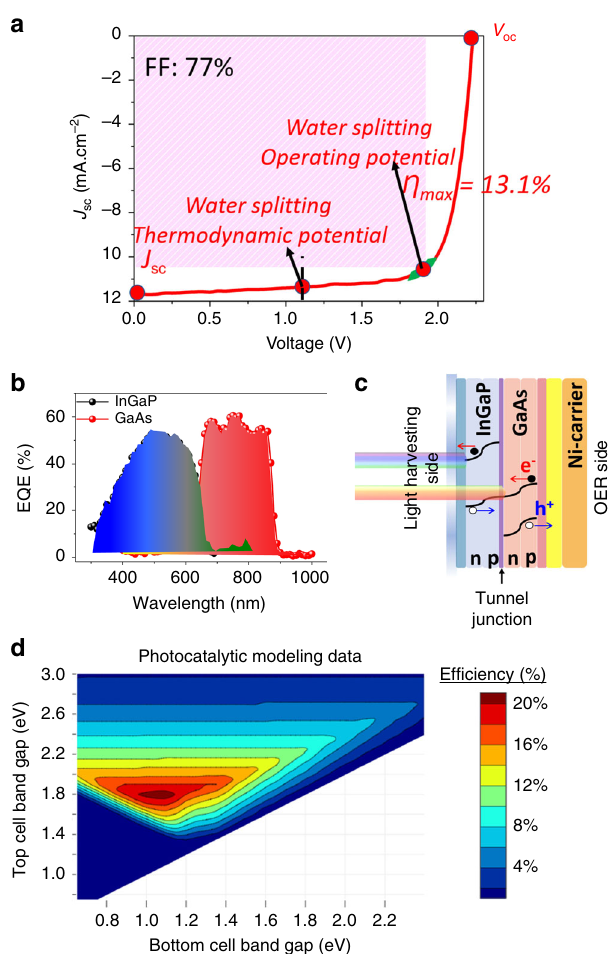
Fig. 2 Photovoltaic characteristics and theoretical modeling of the PEC cell. a PV characteristics of the inverted InGaP/GaAs double junction, consisting of the top cell InGaP structure ( E g = 1.8 – 1.85 eV) and bottom cell GaAs structure ( E g = 1.4 eV) under one sun AM 1.5 G illumination. b EQE measurements and c band-diagram of the InGaP/GaAs tandem photoelectrode. d Solar fuel ef fi ciency modeling using the